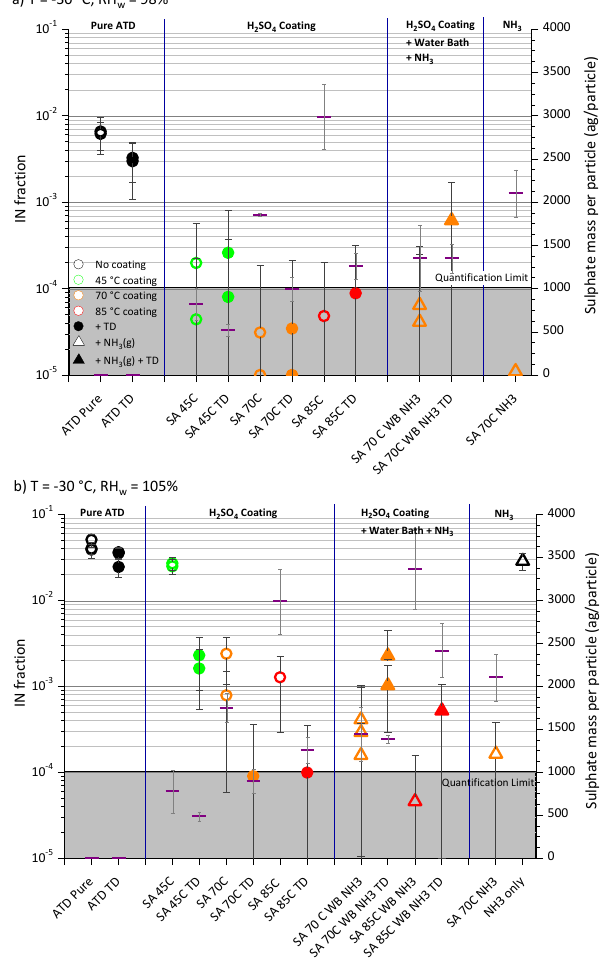
Figure 4 . Fraction of 300 nm ATD particles that nucleated ice after various chemical treatment combinations at -30 °C under (a) deposition-regime ( RH w = 98%) or (b) immersion-regime ( RH w = 105%) ice nucleation conditions. The shaded region of f IN < 10 -4 represents the CFDC’s limit of quantification for these experiments due to background frost counts; no meaning should be ascribed to differences in observed f IN within this region. The average sulphate mass per particle estimated from the AMS is plotted (horizontal line) for each treatment. The error bar corresponds to the standard deviation in f IN between replicates, or the standard deviation of the 1 Hz f IN data when only one replicate was performed. Thermodenuder (TD) temperature was 250 °C in all cases. SA: sulphuric acid, WB: water bath.